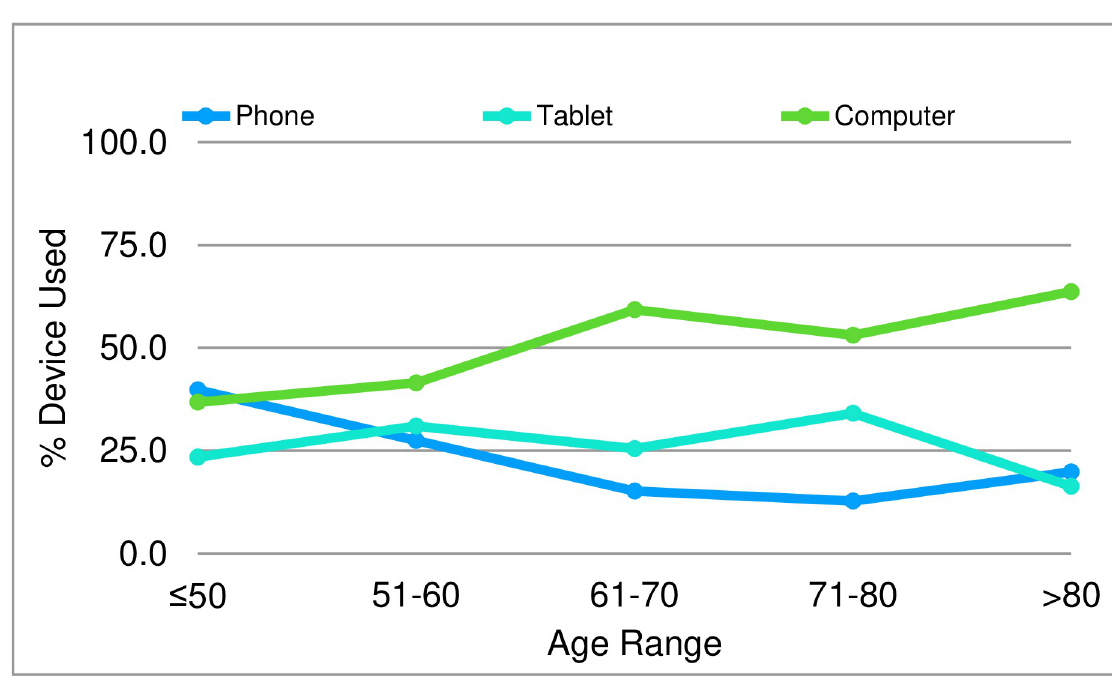
Fig 2. Type of device used to access the ODP dependent upon age group.